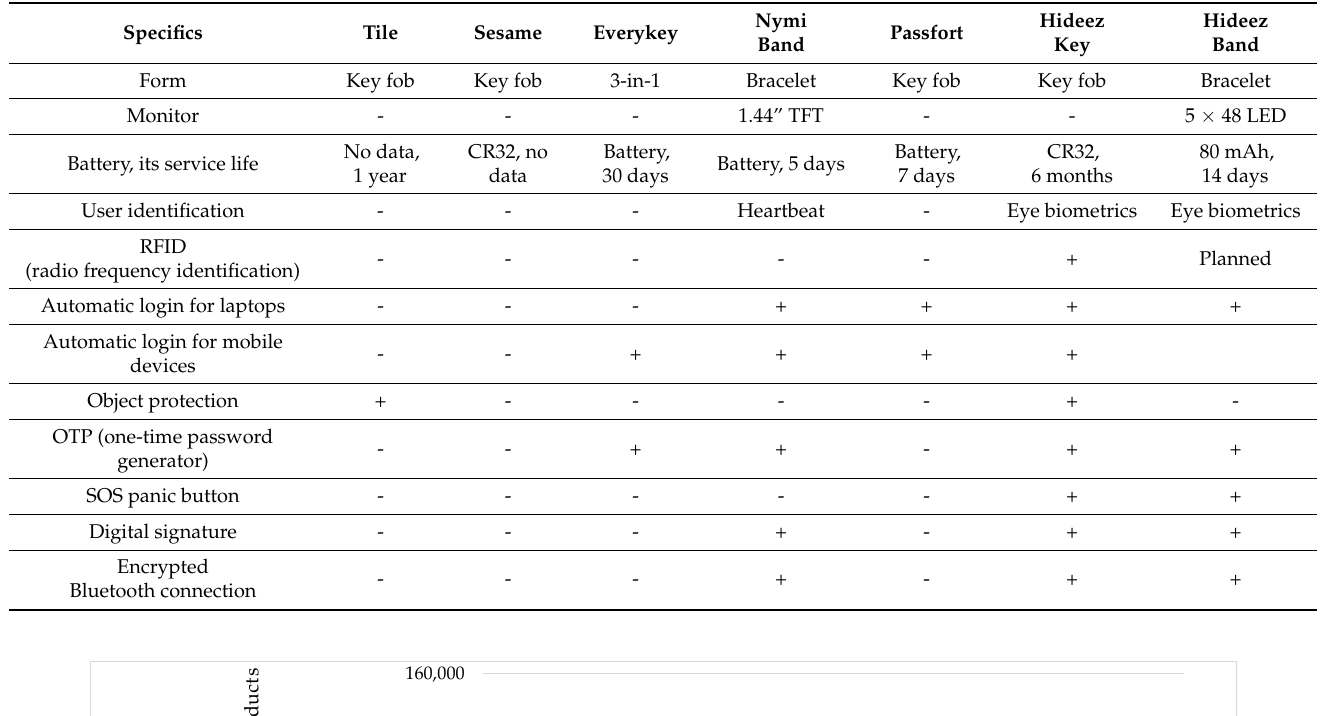
Table 2. Comparison of innovative products of Hideez Technology LTD with the products of major competitors.